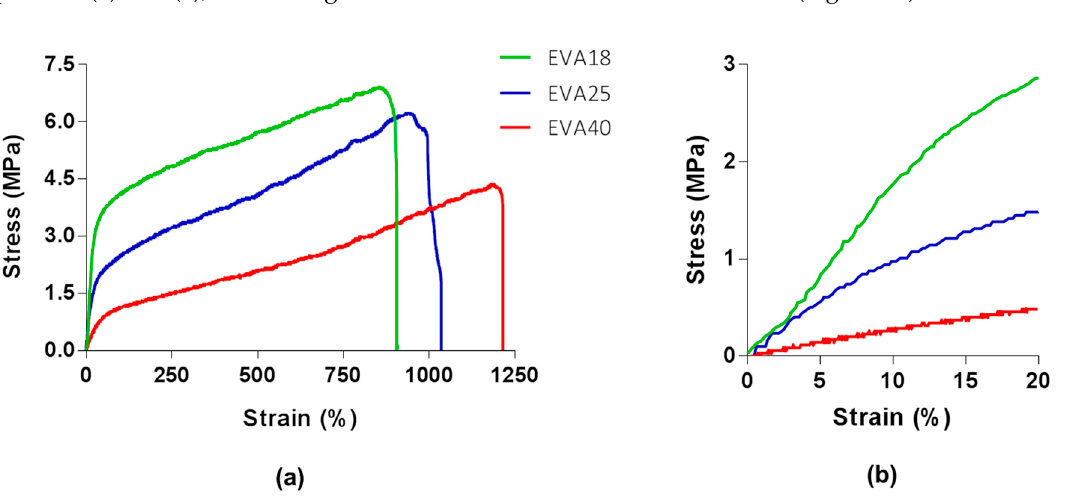
Figure 3. ( a ) Representative stress-strain curves of ethylene vinyl acetate (EVA) formulations at different vinyl acetate (VA) contents, and ( b ) a magnification of the first 20% of deformation.